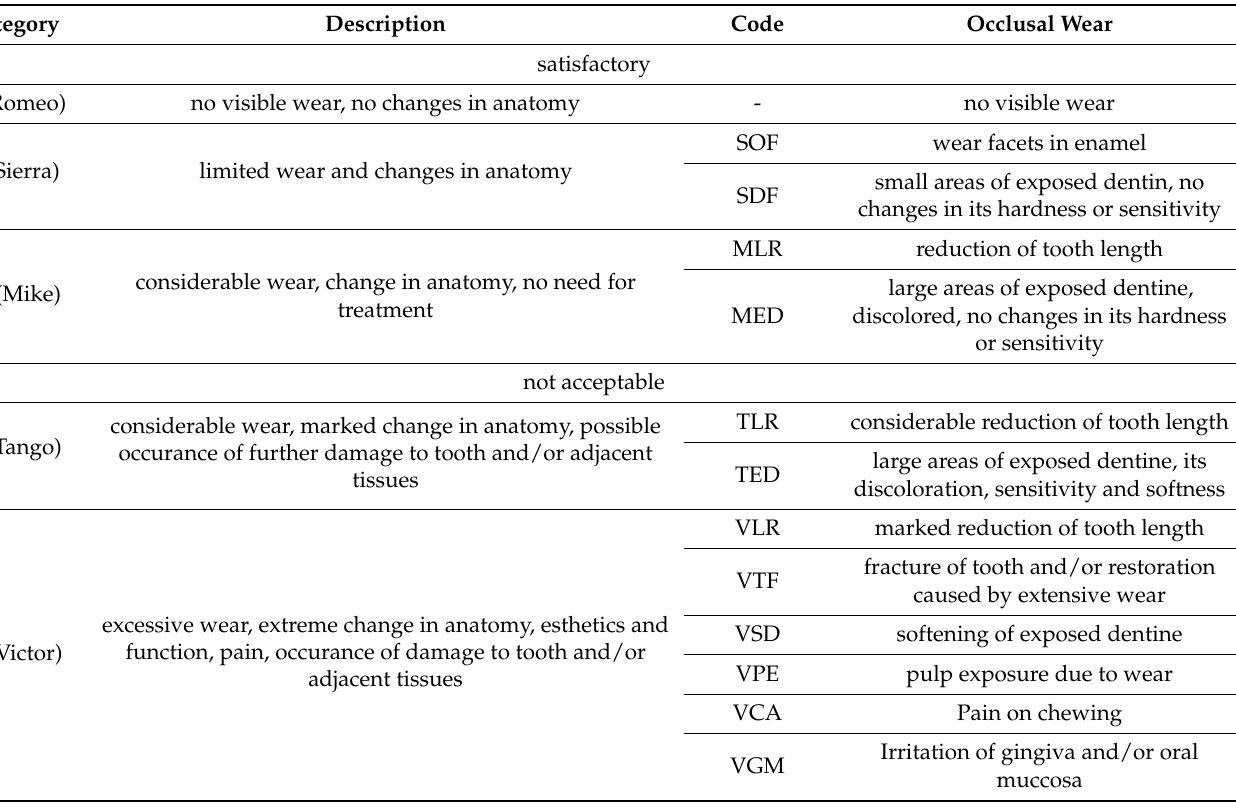
Table 3. Oilo et al.’s index